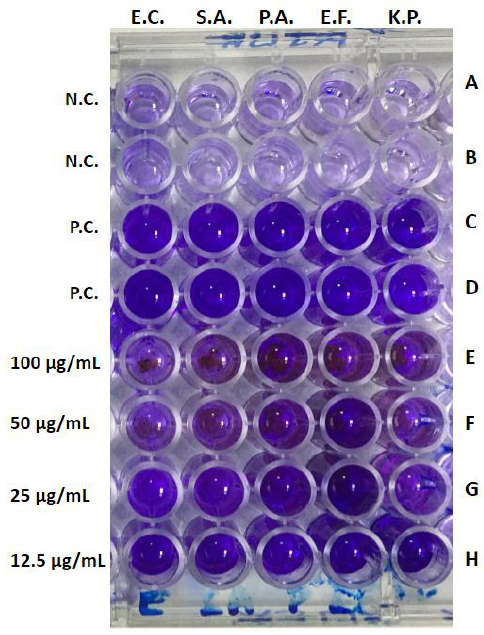
Figure 7. Image showing the screening of biofilm inhibition in the presence of Aw–AgNPs. Rows ( A , B ), negative control (NC): culture media only, no bacterial colony, and no Aw–AgNPs; Row ( C , D ), positive control (PC): culture media plus 5 different bacterial colonies placed accordingly in different wells and no Aw–AgNPs; Row ( E – H ): culture media plus 5 different bacterial colonies placed accordingly in different wells, as well as various concentrations (100 to 12.5 μg/mL) of AgNPs synthesized from Ajwa date extract. EC = indicates Escherichia coli ; SA indicates Staphylococcus aureus ; PA indicates Pseudomonas aeruginosa ; EF indicates Enterococcus faecalis ; KP indicates Klebsiella pneumoniae .